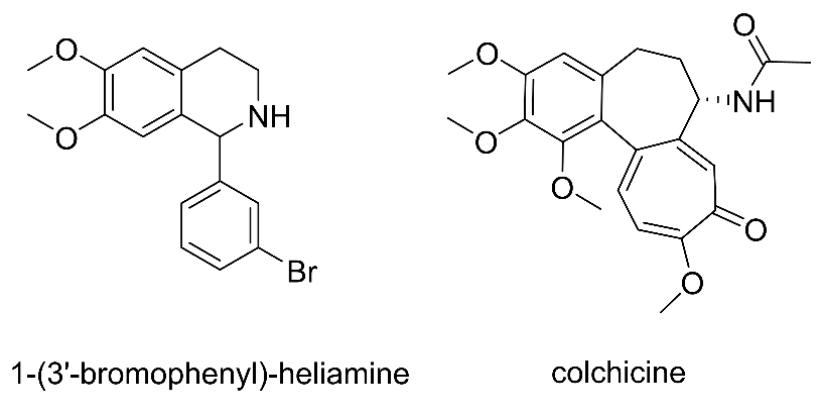
Figure 1. Chemical structures of 1 − ( 3′− bromophenyl) − heliamine and colchicine (internal standard).